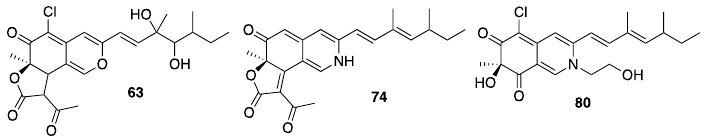
Figure 7. New azaphilone compounds isolated from CN111 extract.